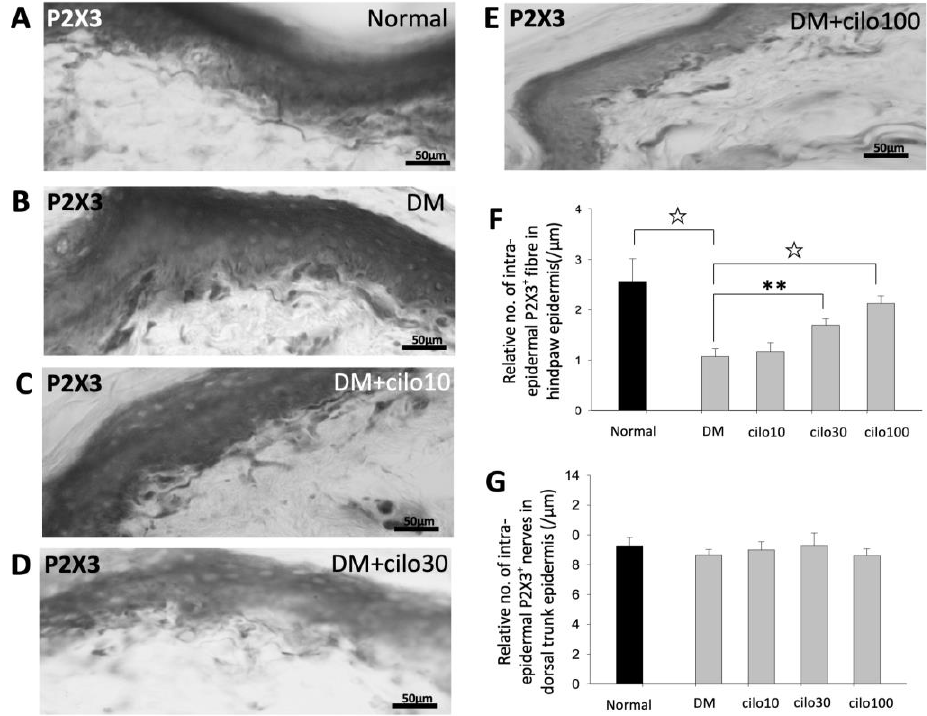
Figure 3. Increased levels of P2X3-positive sensory nerve endings in hind paws of diabetic rats treated with cilostazol (cilo). P2X3 immuno-labeled sensory nerve fibers are indicated by white arrowheads in cryo-sectioned hind paw samples from ( A ) control rats, ( B ) DM rats, and DM rats receiving ( C ) 10 mg/kg (Cilo10), ( D ) 30 mg/kg (Cilo30), and ( E ) 100 mg/kg (Cilo100) daily dosage of cilostazol. Relative density of intra-epidermal P2X3-positive nerve fiber ( F ) in the epidermal layer of hind paws or ( G ) in the epidermal layers of the back trunk skin is shown. Intraepidermal P2X3-positive sensory nerve endings are indicated by white arrowheads in the foot pad. Cilo10, 10 mg/kg cilostazol; Cilo30, 30 mg/kg cilostazol; Cilo100, 100 mg/kg cilostazol. Bars represent the average number of detectable labeled fibers in 5 mm skin sections. ** Indicates p < 0.01, and ☆ at p < 0.001, Mann – Whitney U test. Error bars represent SE.